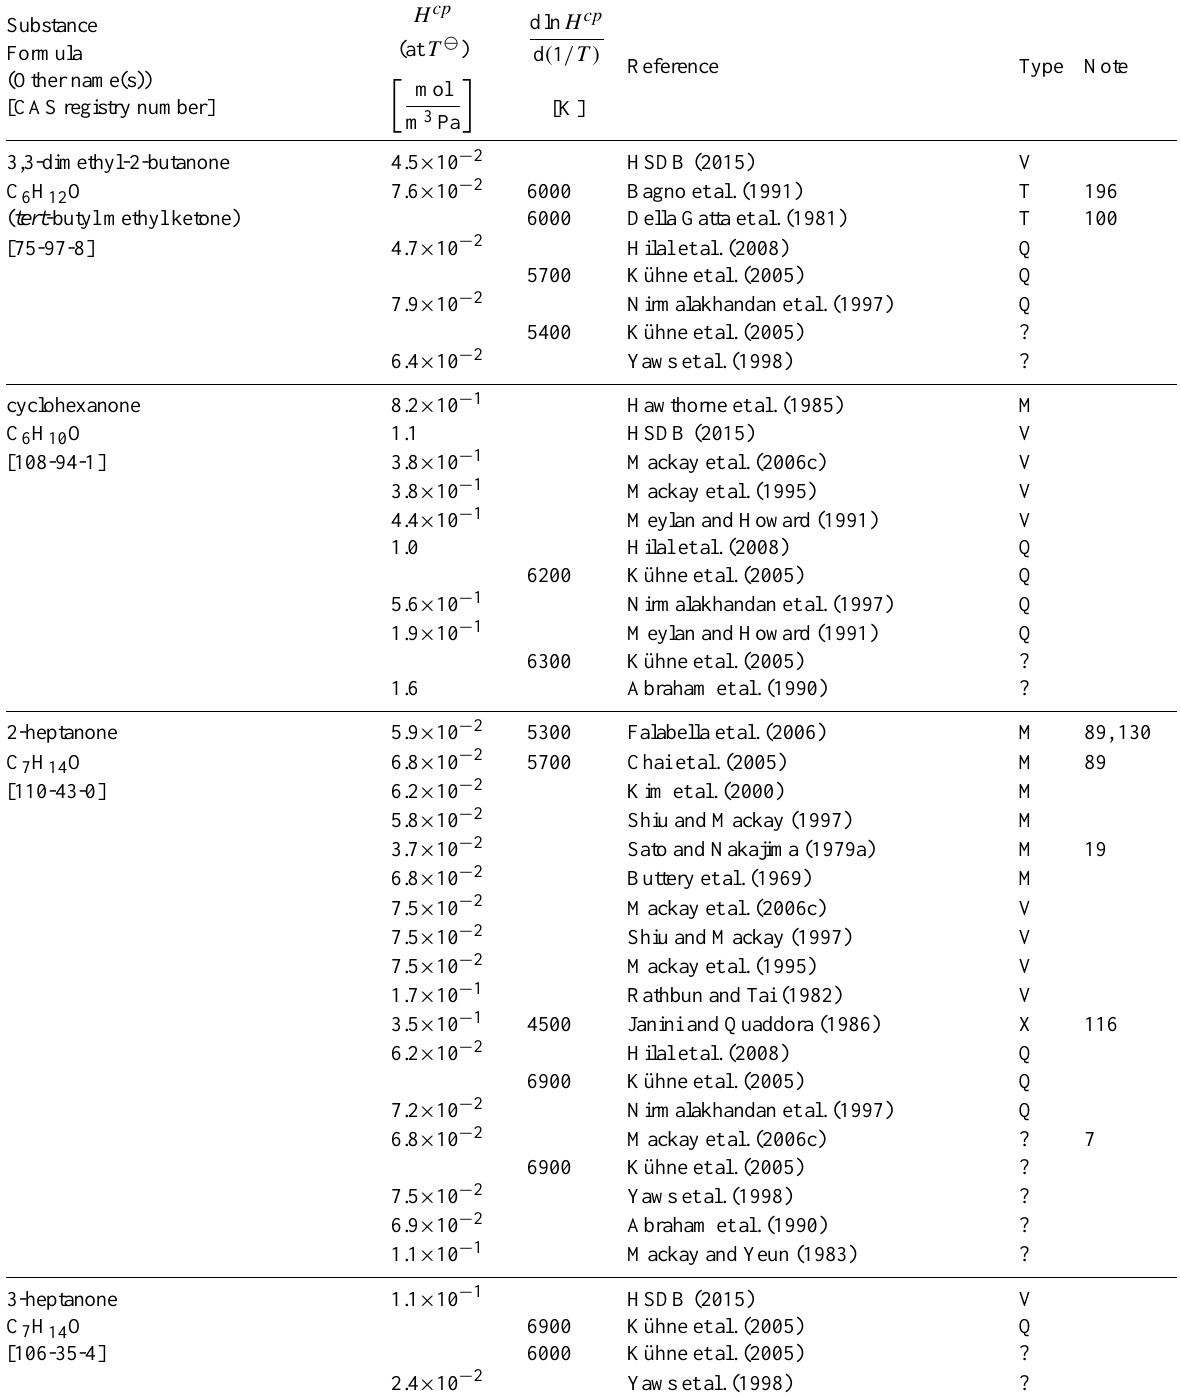
Table 6: Henry’s law constants for water as solvent